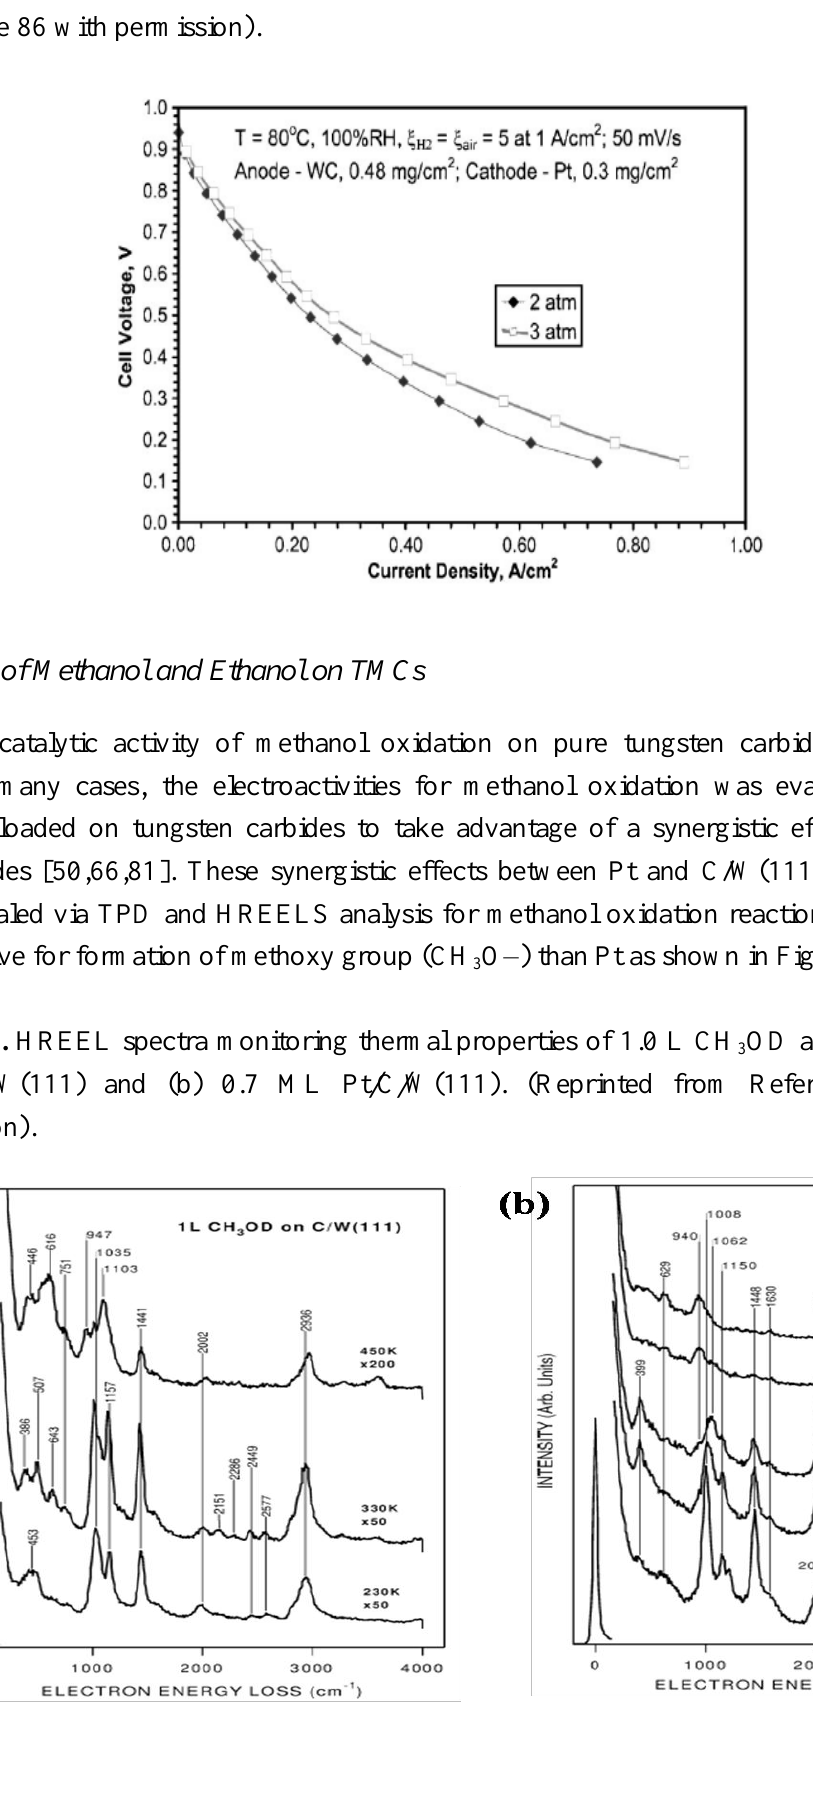
Figure 6. Polarization curves of the tungsten carbide-based anode in a 5 cm 2 single cell with fully humidified H / air at flow rates of 0.2/0.5 slpm and 80 °C (Reprinted from 2 Reference 86 with permission).